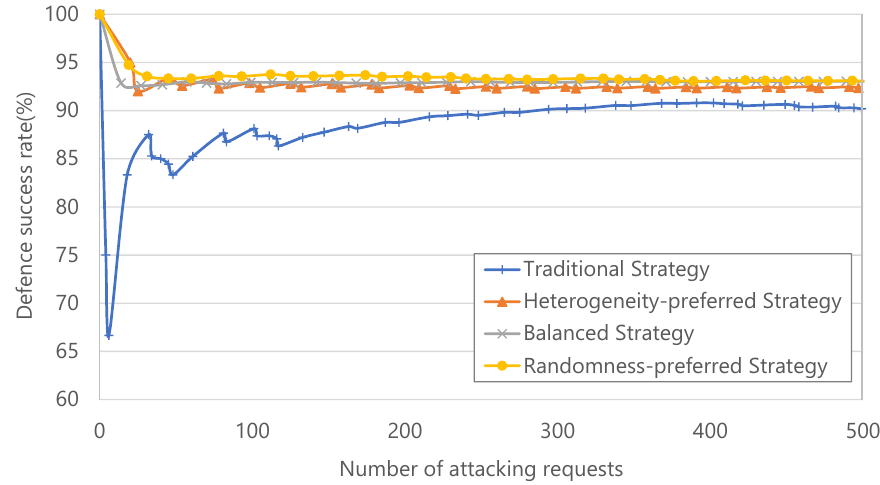
Figure 8. Defence success rate under the continuous attack scenario.